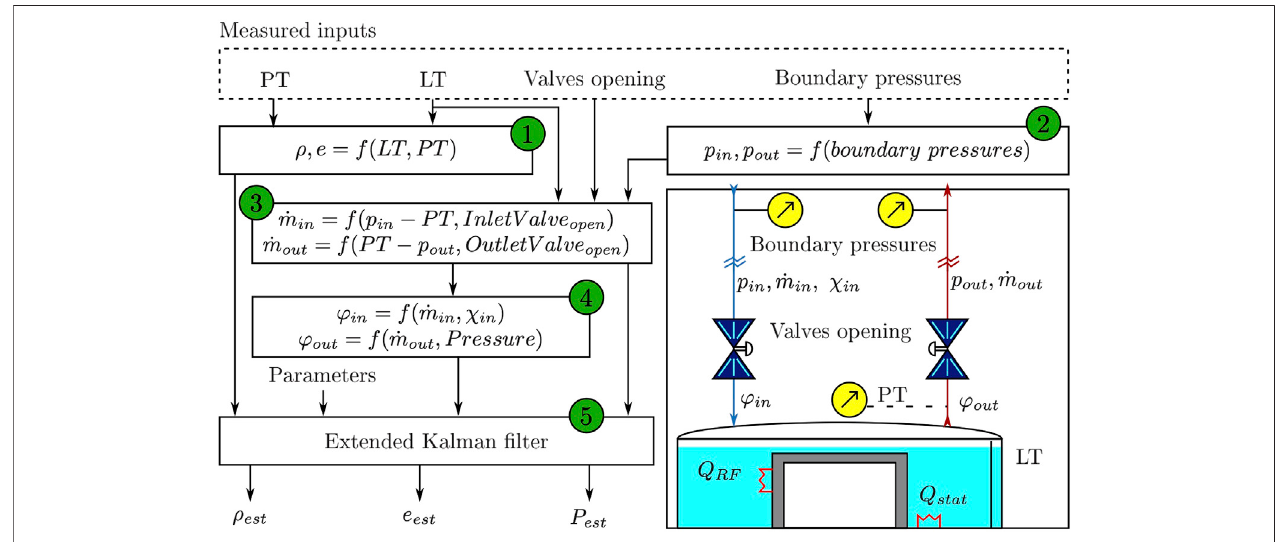
FIGURE 6 | Block diagram of the virtual sensor and its associated model schematic view. f designates different functions depending on the associated bloc number. LT and PT are, respectively, level and pressure transmitters. Numbers within green circles are explained in the text.